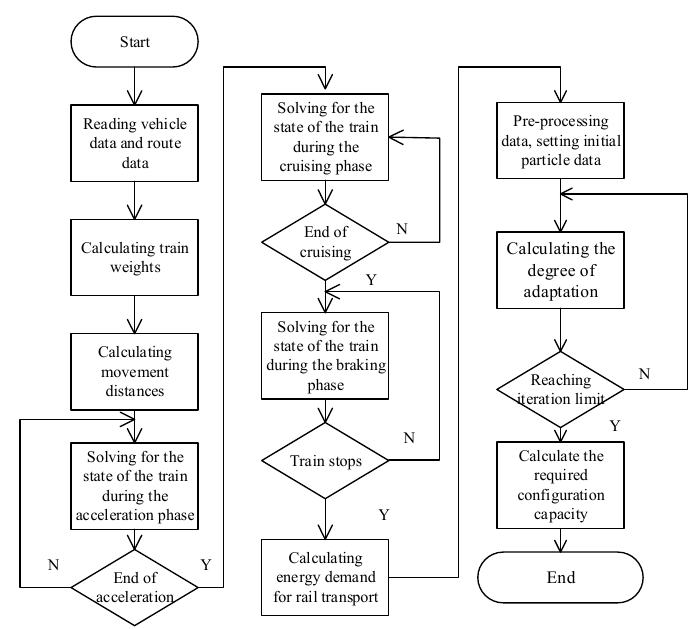
Figure 5. Optimization strategy solving process.